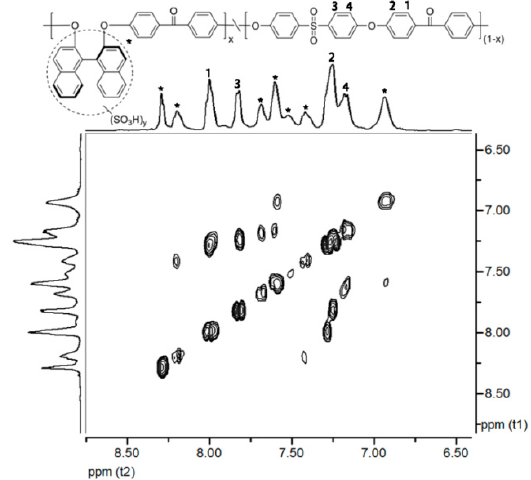
Figure 4. 2D 1 H– 1 H COSY NMR spectrum of SPAEK-50 in DMSO-d 6 .